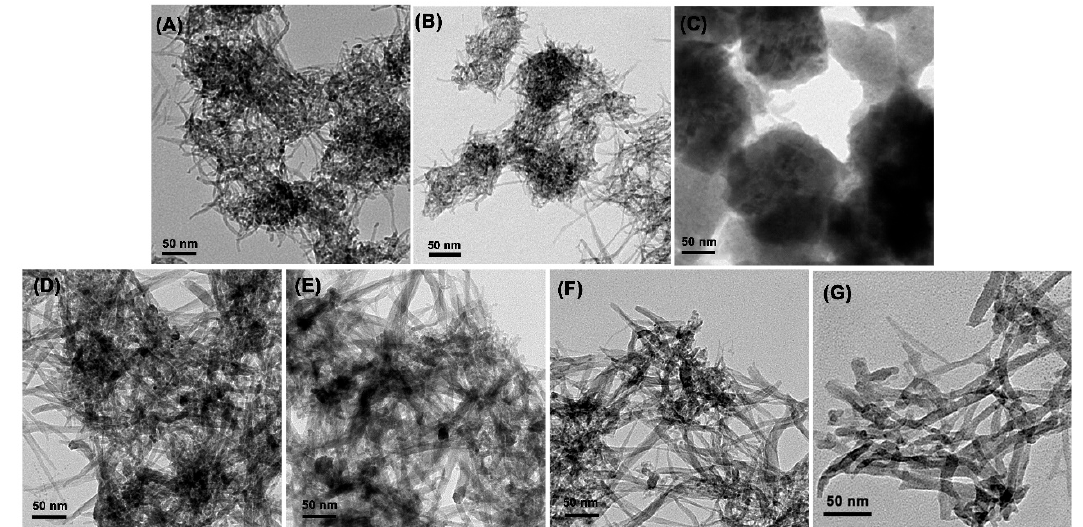
Figure 4. TEM images of the prepared Cu 2 O on different conditions: without polyvinyl pyrrolidone (PVP) ( A ); NaOH (0.2 M) increased to 3 mL ( B ) and 4 mL ( C ); different microwaving times: 2 min ( C ), 4 min ( D ), 6 min ( E ), 8 min ( F ); possible formation route of the prepared one-dimensional Cu 2 O.